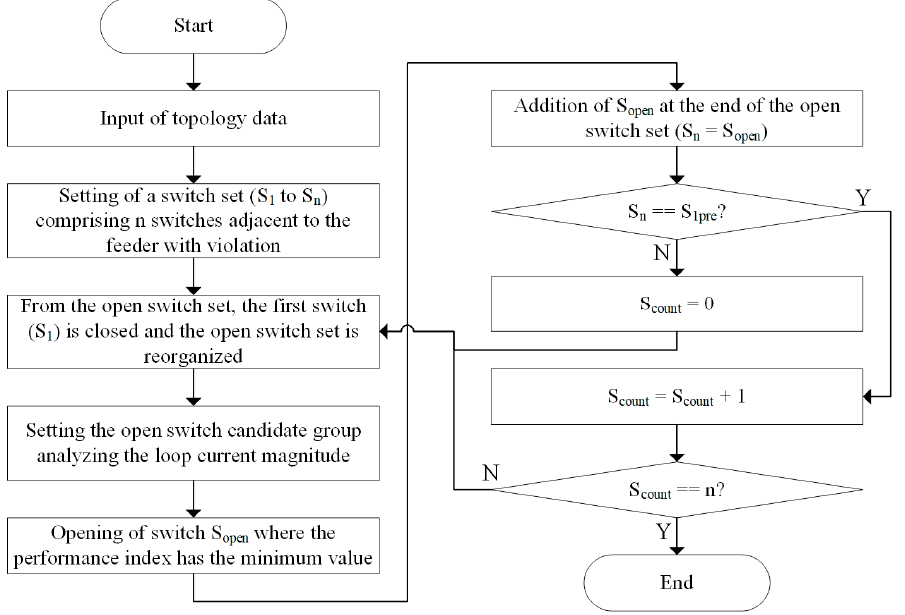
Figure 7. Flowchart of the network reconfiguration.